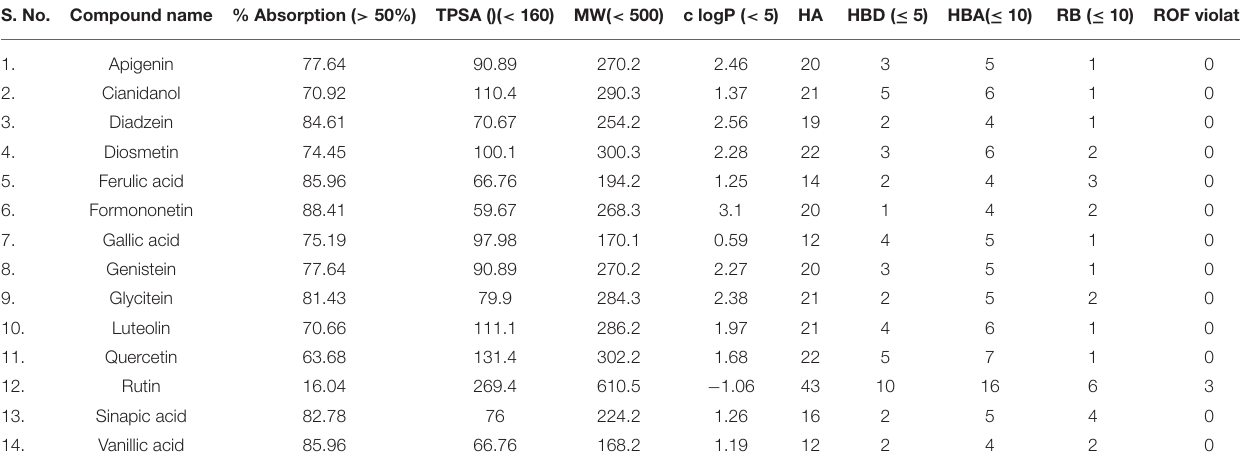
TABLE 2 | Physicochemical properties of palm date